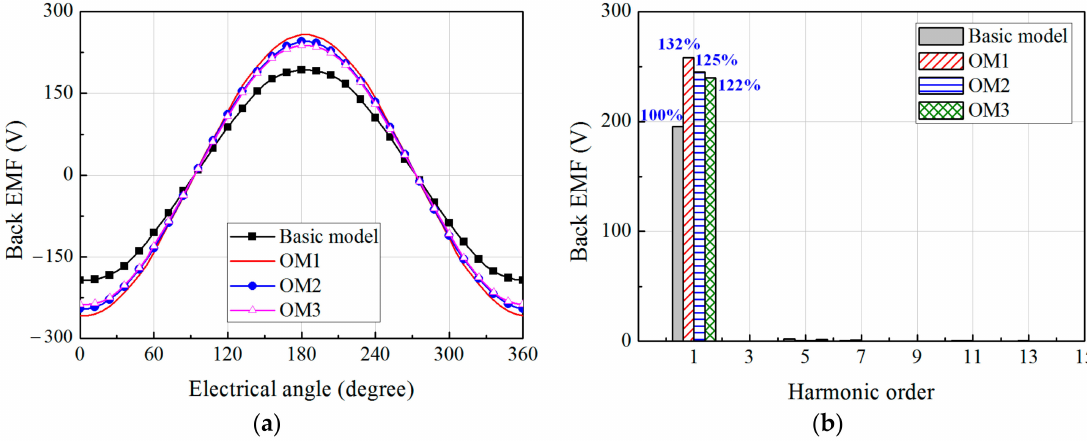
Figure 14. Back electro motive force (EMF) characteristics of the basic and optimal models. ( a ) Waveforms; ( b ) Harmonic